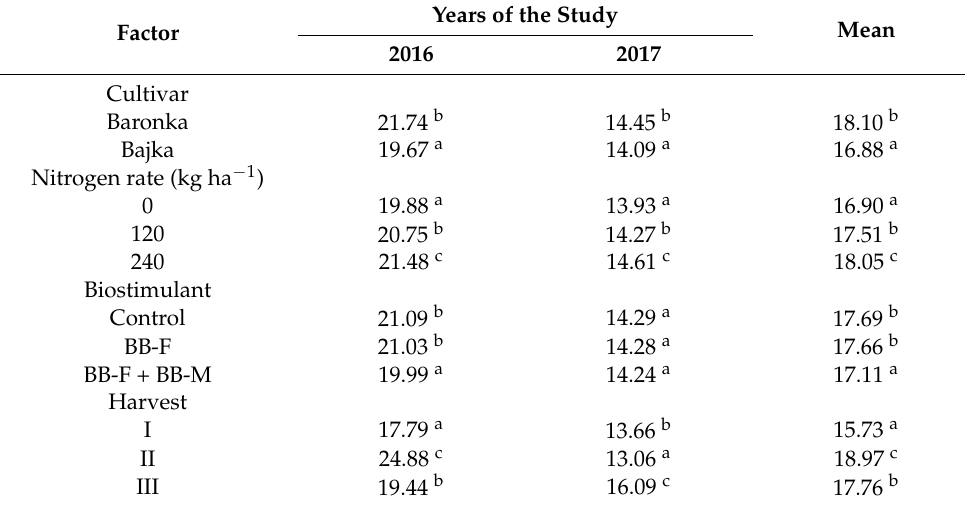
Table 6. Content of potassium in perennial ryegrass biomass (g kg − 1 DM).